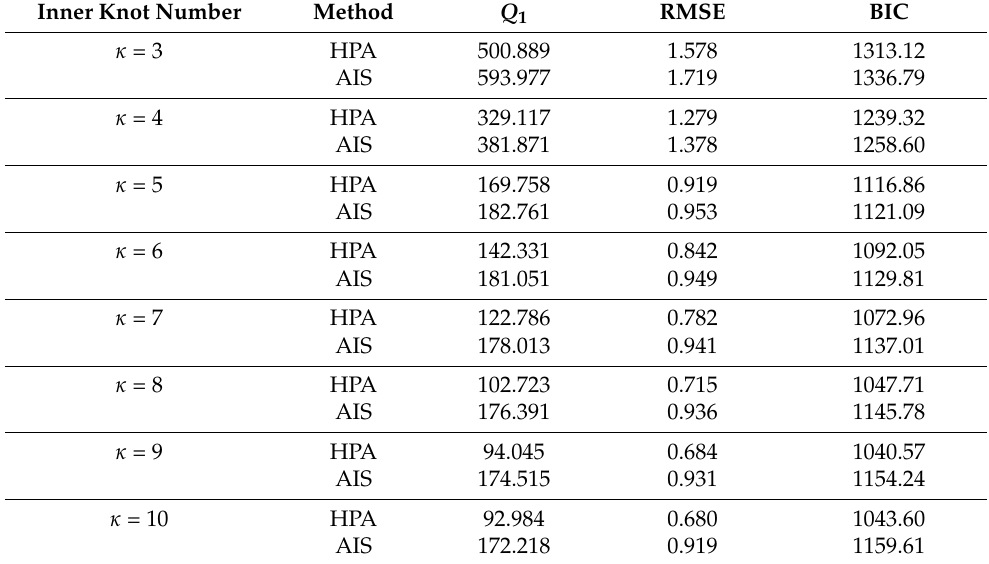
Table 5. BIC values of AIS and HPA methods at the same